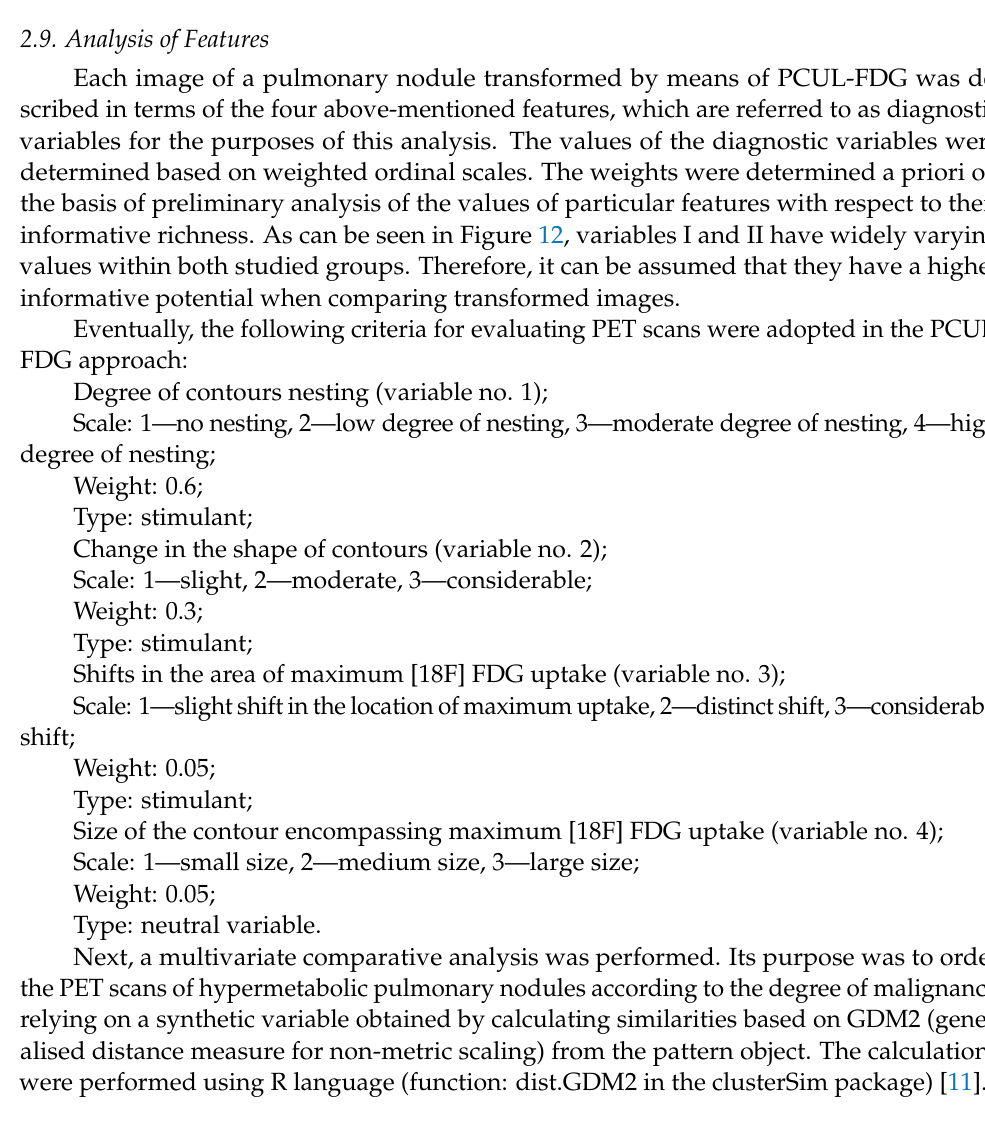
Figure 11. Examples of different sizes of contours encompassing maximum [18F] FDG uptake in four different pulmonary nodules. ( A ) Large size, ( B , C ) medium size, ( D ) small size.